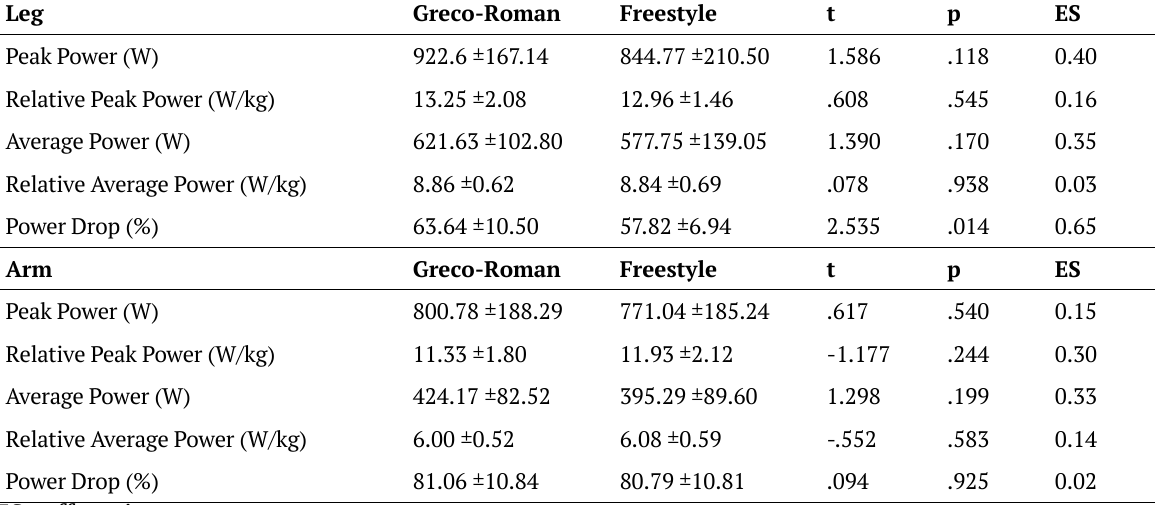
Table 2. Comparison of leg and arm anaerobic power and